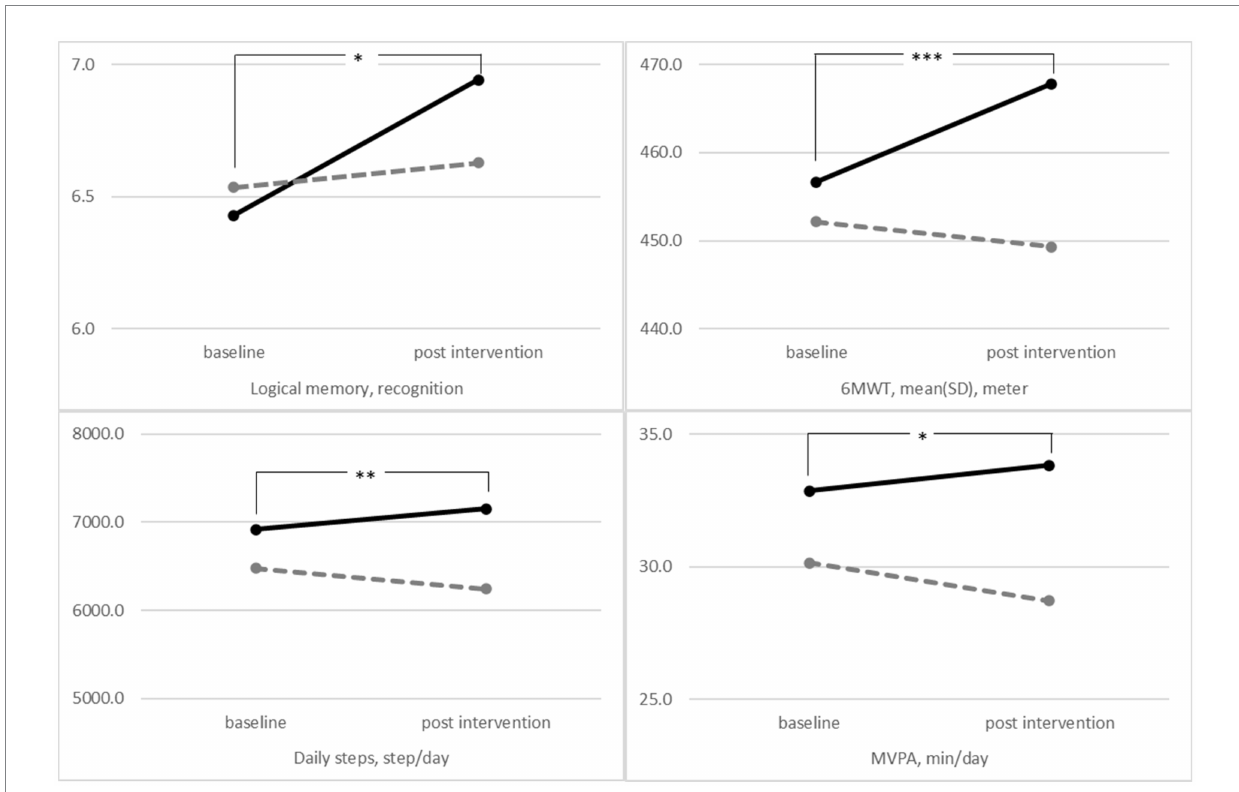
FIGURE 2 The mean performance of the intervention group (solid lines) and control group (dashed lines) at baseline and 10 months post-intervention after controlling for the covariates values of sex, age, education level, and the number of medications using the repeated-measures analysis of covariance. (Logical memory p = 0.026, 6MWT p < 0.001, average daily step p = 0.005, and MVPA p = 0.033). 6MWT, 6-min walking test; MVPA, moderate-to-vigorous physical activity. * p < 0.05, ** p < 0.01, and *** p <